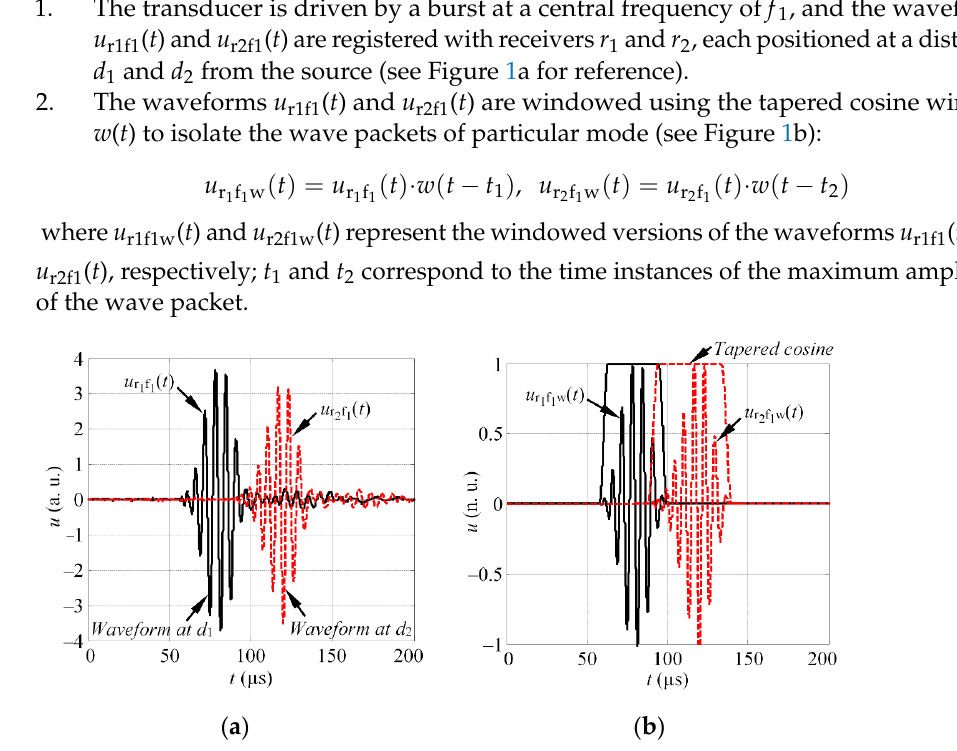
Figure 1. ( a ) The example of the waveform, registered with receivers r 1 and r 2 , at distances d 1 and d 2 ; ( b ) the illustration of waveform windowing to isolate the wave packet of single